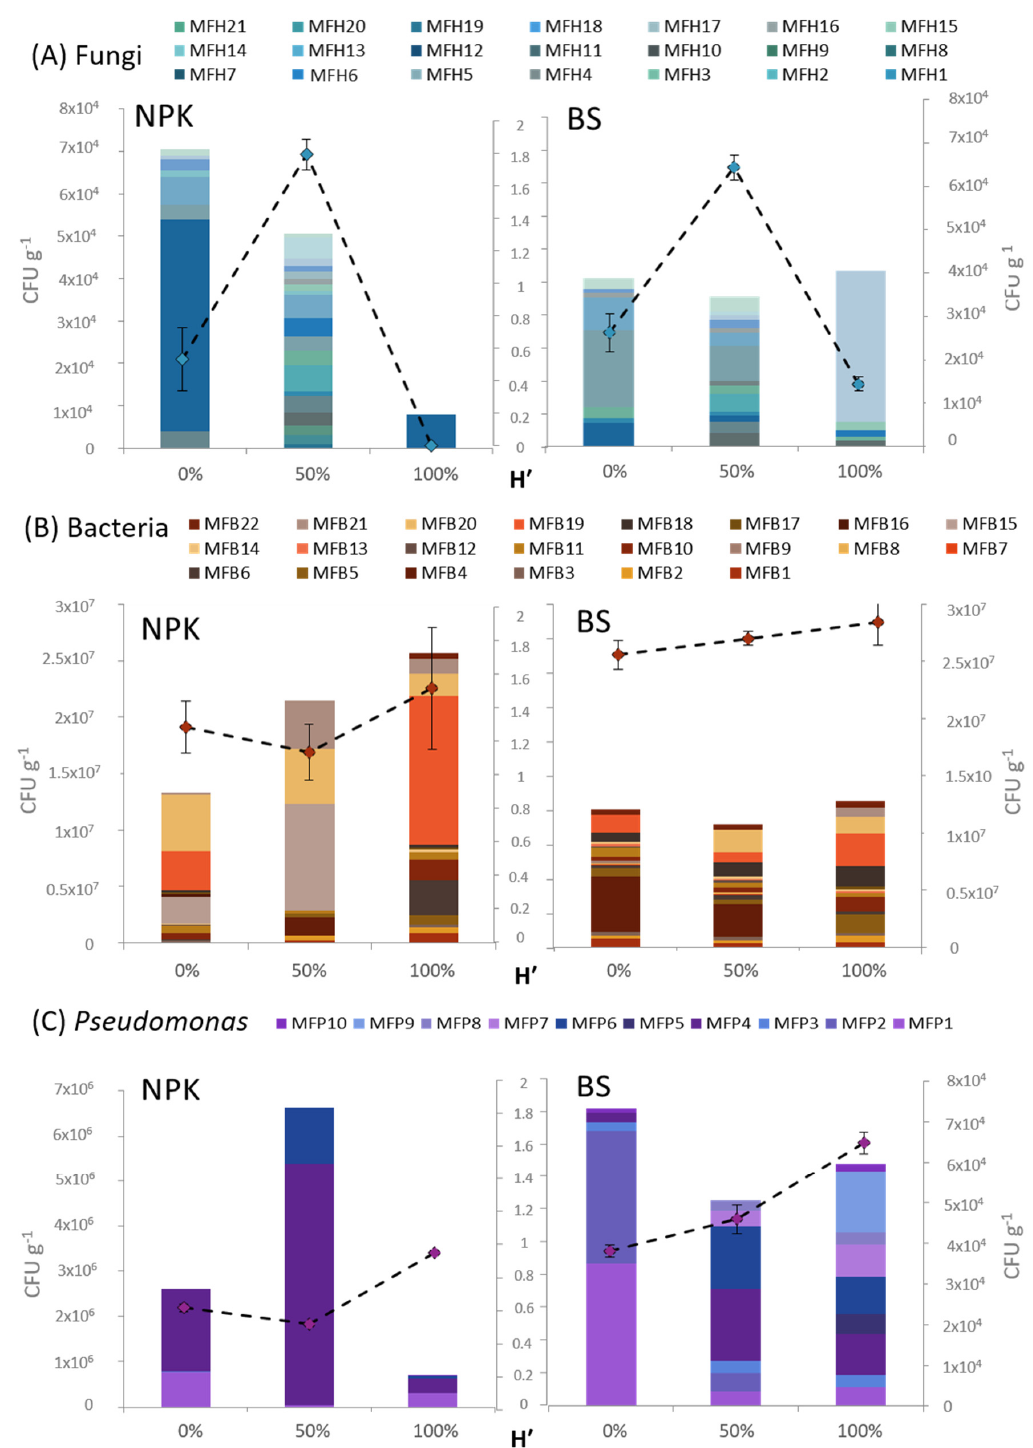
Figure 6. Cultivable fungi ( A ), bacteria ( B ) and bacteria from Pseudomonas genus ( C ) isolated from rhizosphere soil of chestnut seedlings grown for 8 months on different substrate mixtures (compost: 0%, 50% and 100%). Bars show microorganism quantity in colony formation units per gram of soil (CFU/g) as the sum of the quantity of all morphotypes found in each treatment (represented with different colors within each group. MFH, fungal morphotypes; MFB, bacterial morphotypes; MFP, Pseudomonas morphotypes). Dotted line graphs show changes in Shannon diversity index (H (cid:48) ) for each treatment. Values represent mean ± SE ( n =